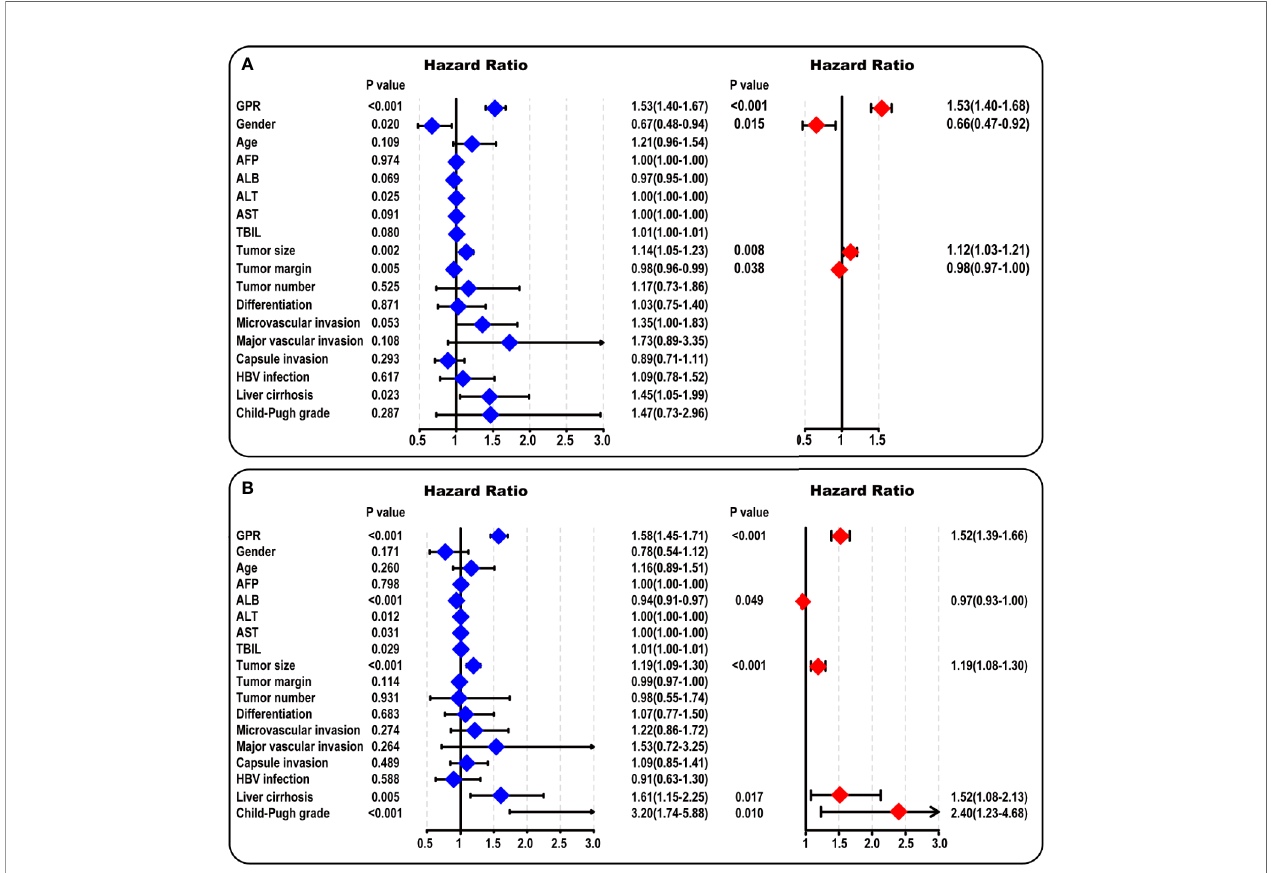
FIGURE 2 | Univariate and multivariate analysis in the training cohort. (A) The forest map results of the univariate and multivariate survival analysis of DFS among HCC patients are shown. (B) The forest map results of the univariate and multivariate survival analysis of OS among HCC patients are shown. AFP, a -fetoprotein; ALB, albumin; ALT, alanine aminotransferase; AST, aspartate aminotransferase; TBIL, total bilirubin; HBV, hepatitis B virus; GPR, gamma ‐ glutamyl transpeptidase ‐ to ‐ platelet ratio; HCC, hepatocellular